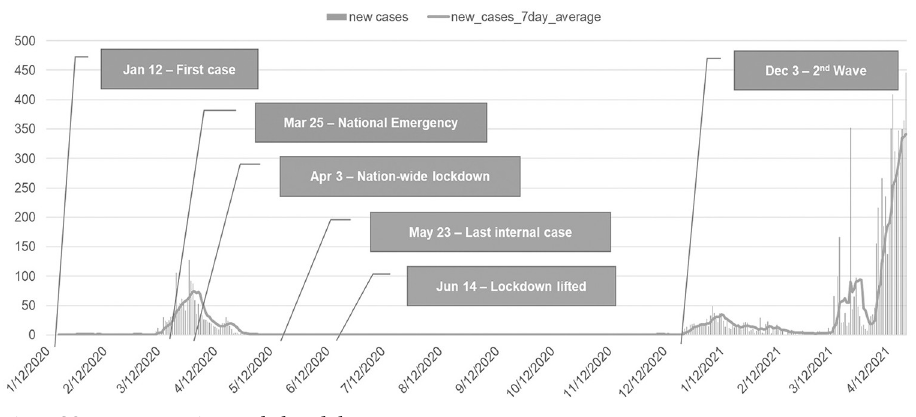
Fig 2. COVID-19 cases in Bangkok and the government